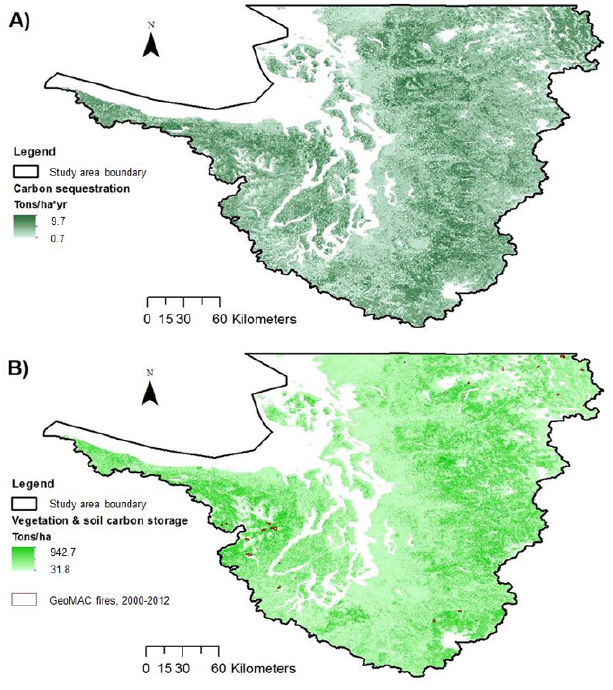
Fig. 3 . Carbon (a) sequestration and (b) storage in the Puget Sound